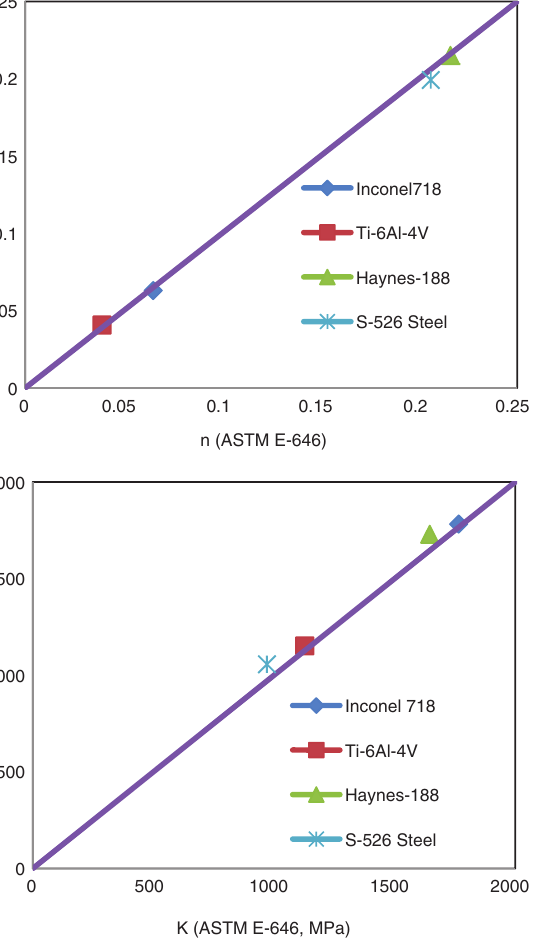
Figure 6 Comparison of present methodology with ASTM E-646 for (A) strain hardening exponent and (B) strength co-efficient for Ti-6Al-4V for high temperature data from MMPDS